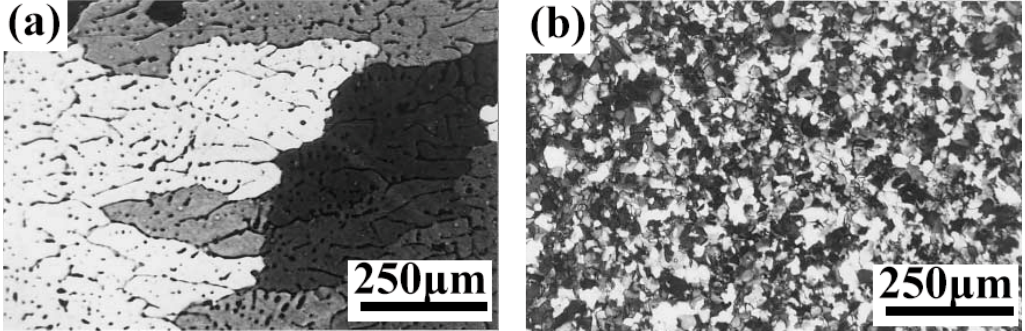
Figure 3. Optical microstructure (OM) structure [57]: ( a ) Al-0.2Sc, ( b ) Al-0.7Sc. Reprinted with permission from [57], 1998, Elsevier .